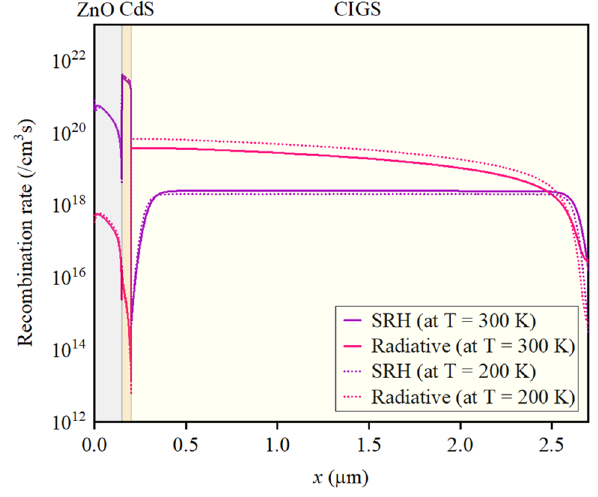
Figure 9. SRH and radiative recombination profile at V = V OC (T = 200 K and 300 K) under one sun illumination (AM 1.5) for baseline structure of CIGS without the presence of MoSe 2 interface layer. Light yellow region represents CIGS absorber, deep yellow area is CdS buffer, and ZnO window layer is indicated as the grey region.